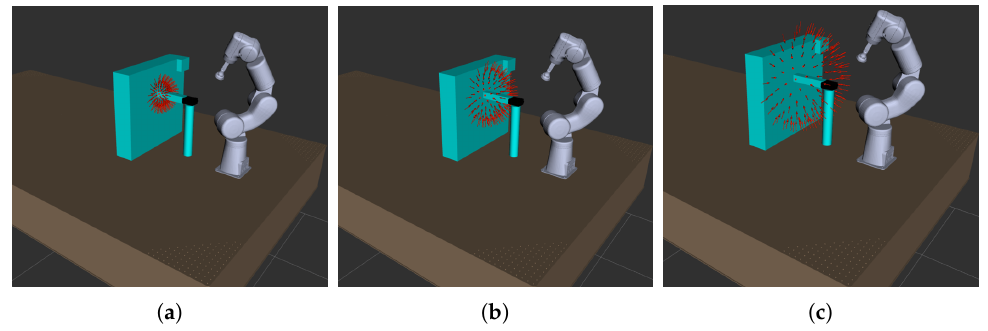
Figure 6. Dome configurations with variable radius. The radius of the dome can be adjusted from a few cm to 30 cm with this robot arm. ( a ) Hemisphere radius = 15 cm. ( b ) Hemisphere radius = 20 cm. ( c ) Hemisphere radius = 25 cm.